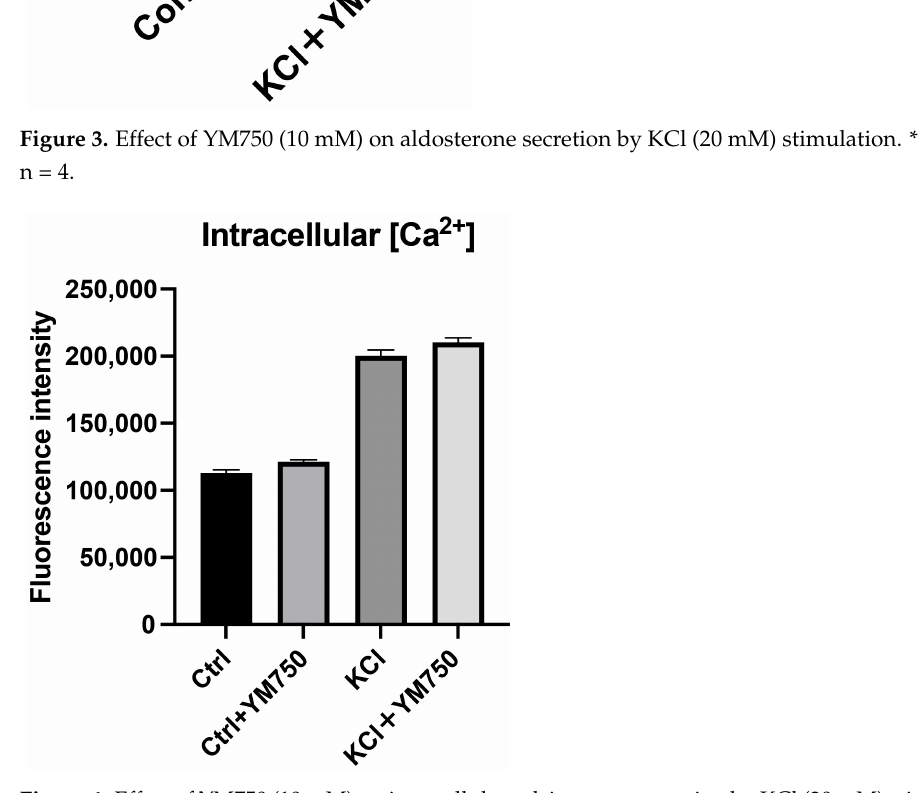
Figure 3. Effect of YM750 (10 mM) on aldosterone secretion by KCl (20 mM) stimulation. * p < 0.05, n = 4.